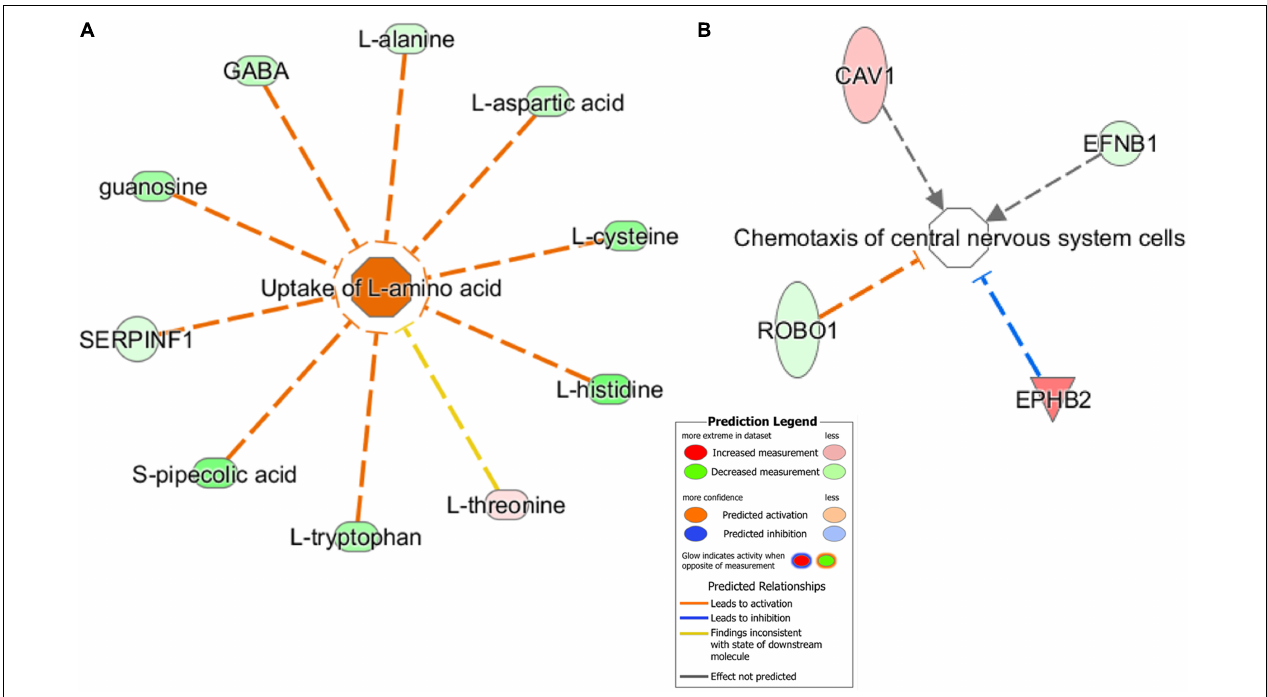
FIGURE 6 | Predicted biological functions of the significantly changed metabolites and proteins were identified by IPA. (A) “Uptake of L-amino acid” and (B) “Chemotaxis of central nervous system cells.” Each molecule node is connected to the relevant functional nodes. Molecule symbols in red were upregulated while green symbols were downregulated in the LPS group. Different colored lines and nodes represent different meanings, similar to “Prediction